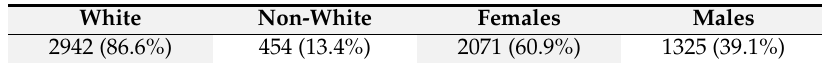
Table 4. Ethnicity and gender of e-survey